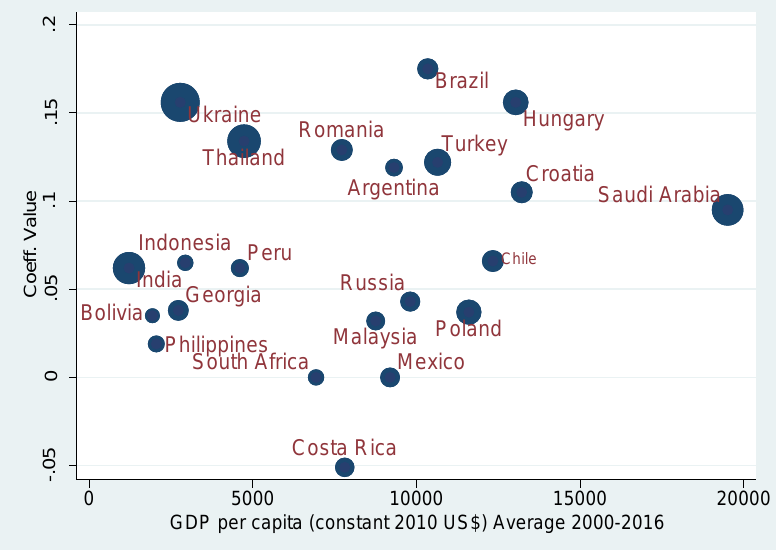
Figure 3 : Weak correlation between development level and benefits from imports from China